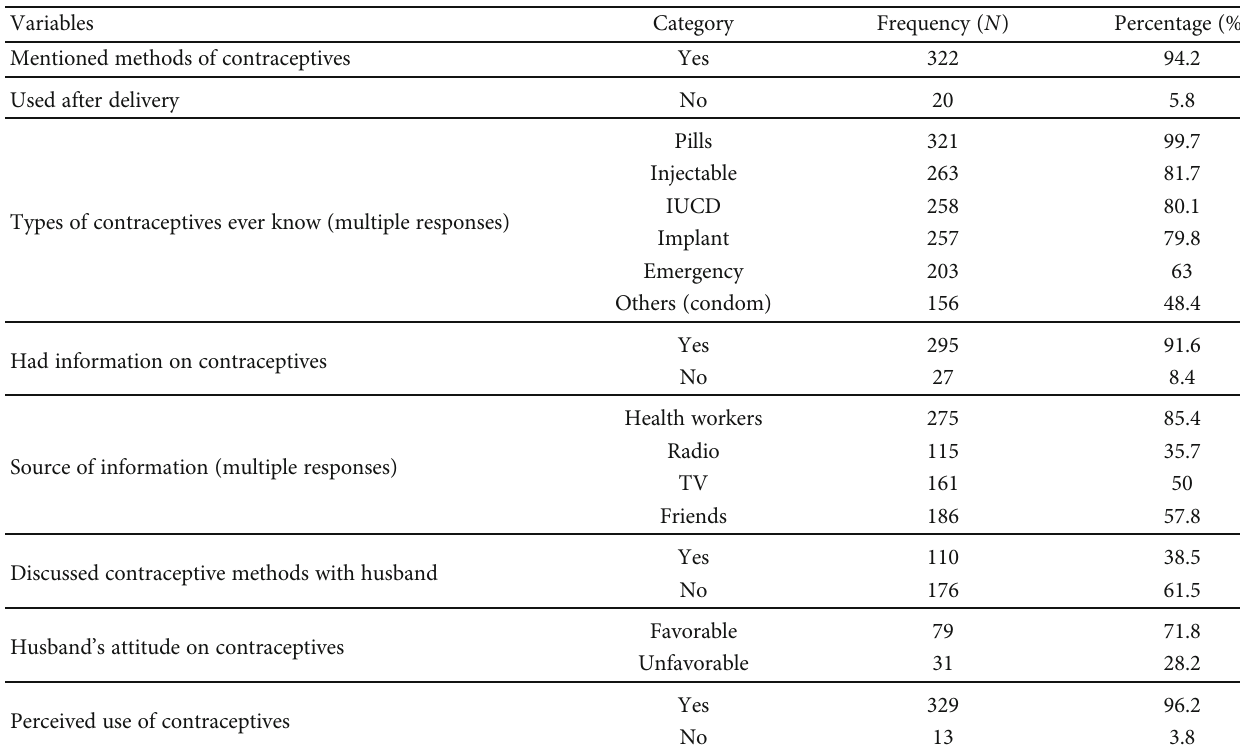
Table 3: Knowledge and attitude of the study participants on contraceptive use in Dubti town, pastoral community, Afar region, Northeast Ethiopia, May